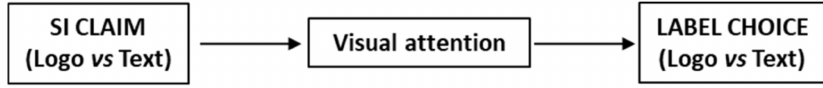
Figure 2. Initial hypothesis about the relation between visual attention and